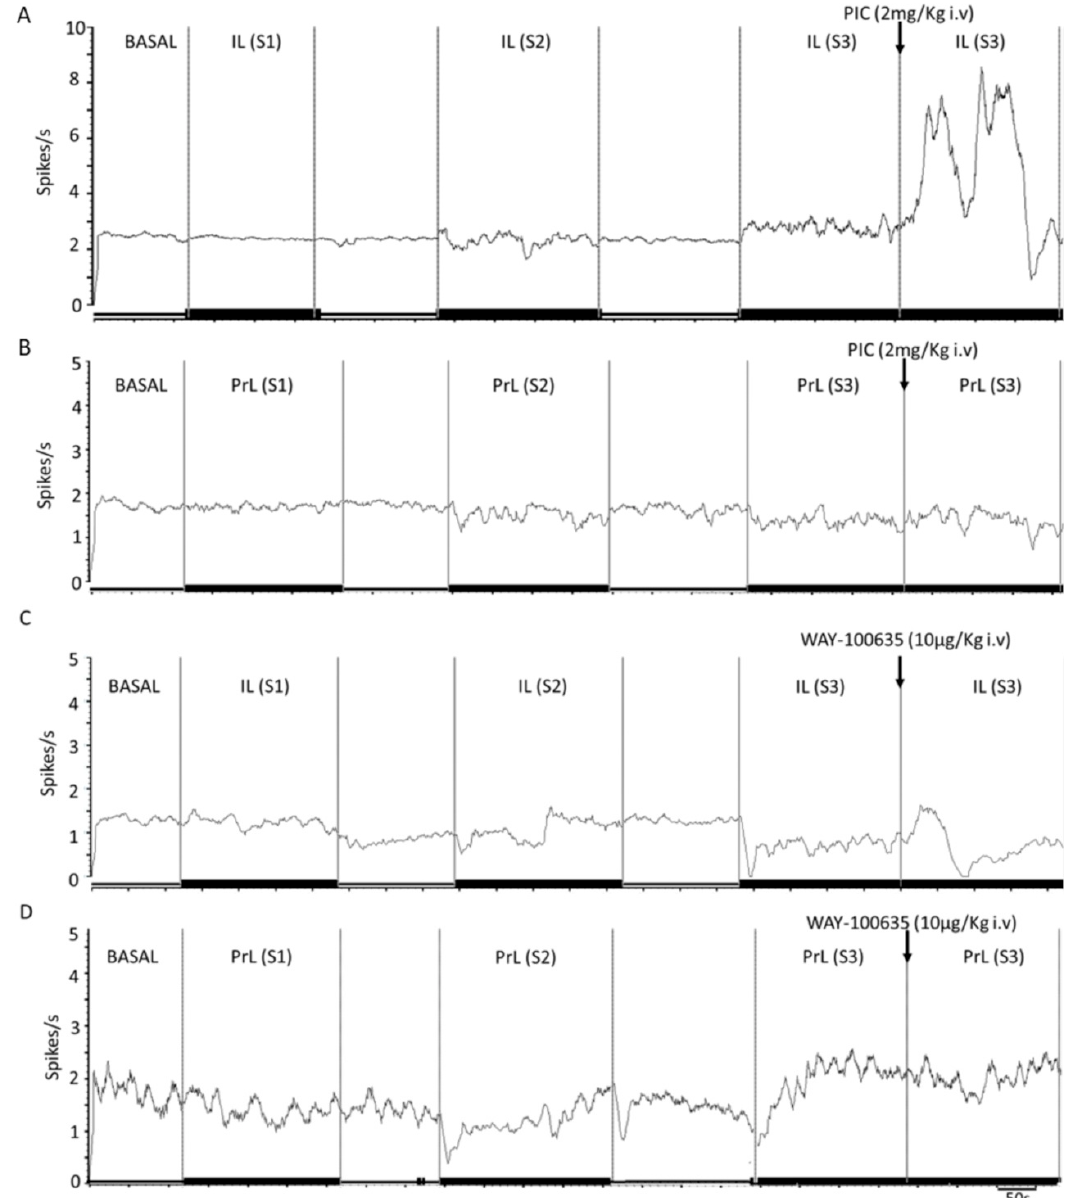
Figure 5. Involvement of 5-HT 1A and GABA A receptors in IL- and PrL-induced responses in DR 5-HT neurons. ( A – D ) Mean frequency graphs showing spikes/s of representative recordings of DR 5-HT neurons during IL and PrL stimulation at increasing frequencies (S1: 0.9 Hz, 0.2 ms, 1.7 mA; S2: 10 Hz, 1 ms, 0.5 mA; S3: 20 Hz, 1 ms, 0.5 mA) and pharmacological effects of picrotoxinin (PIC, GABA A -R antagonist) ( A , B ) and WAY-100635 (5-HT 1A -R antagonist) ( C , D ) during S3 stimulation. Note that PIC (but not WAY-100635) increased serotonergic discharge during IL stimulation above values under S3 conditions ( A ).